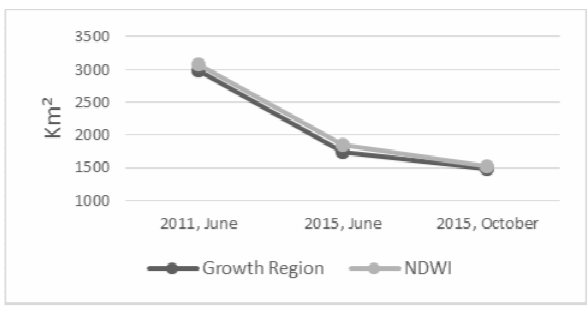
Figure 6: Reservoir detected using the image from June 2011.